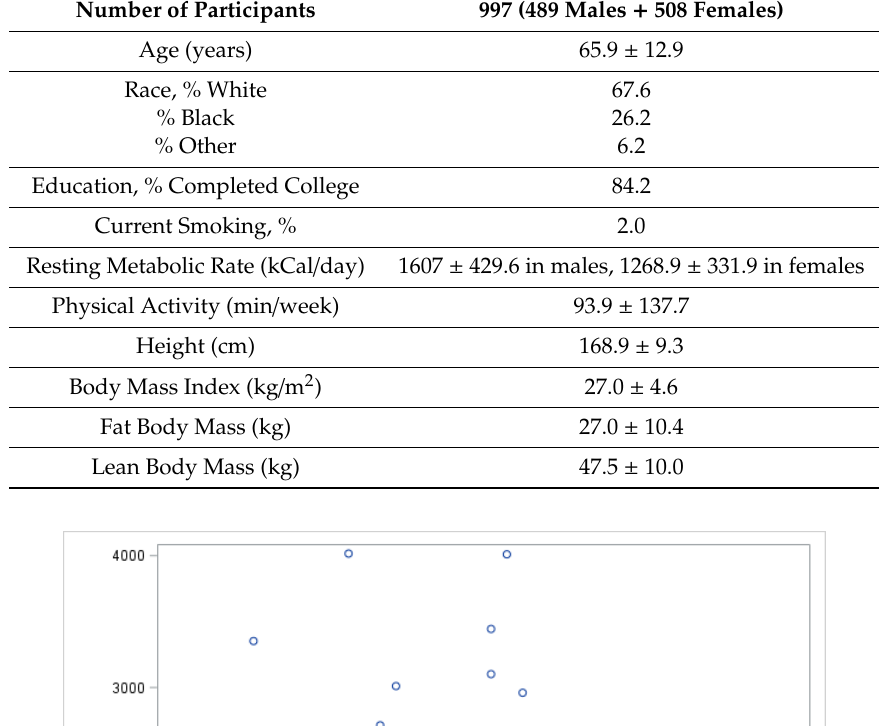
Table 1. Characteristics of the population at baseline (average ± standard deviation).